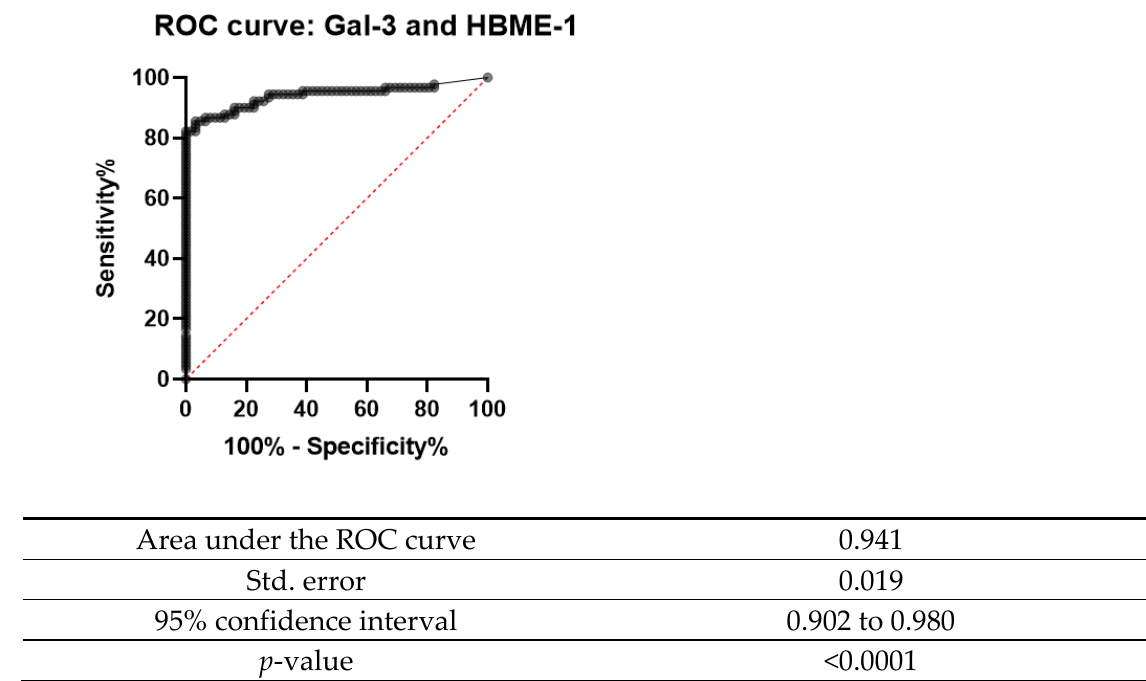
Figure 8. ROC curve for Gal-3 and HBME-1 combined.